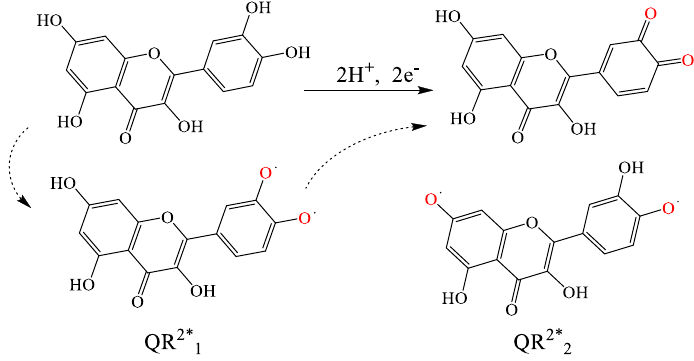
Figure 7. The schemata of the oxidation of QR.